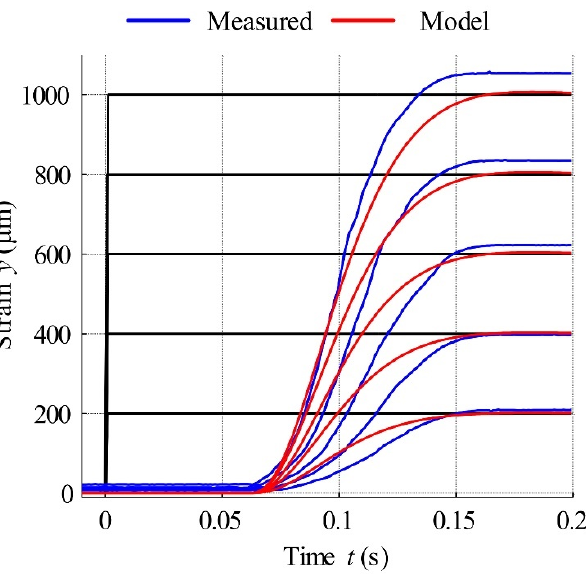
Figure 22. Step responses of actuator and simulation model described by Equation (23).